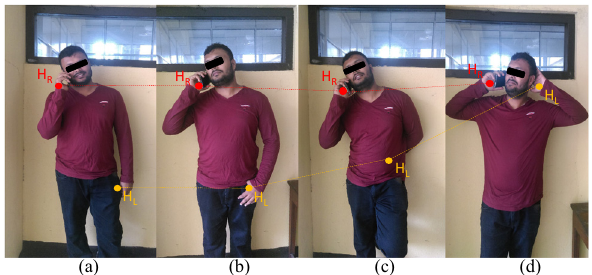
Figure 1: An example situation in which an individual is making a call. The points in space to which the right and left wrists move within a period are marked in ( a ) to ( d ) . Variation in the positions of two joints; right wrist ( ) H R and left wrist ( ) H L are joined for the ease of comparison of variation. Shown in yellow and blue are the positions of right and left wrist,